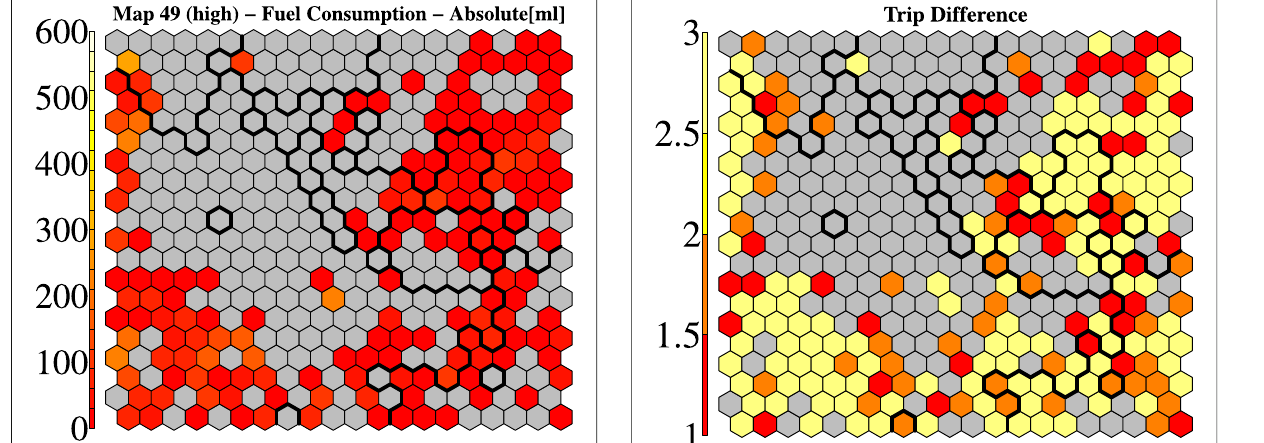
Fig. 14 Difference between Trip 49 and Trip 53. Red represents manoeuvres only found in trip 49. Orange represents manoeuvres only found in trip 53 and Yellow represents manoeuvres common to both 79 are plotted in Figs. 15 and 16, respectively. In node 79,